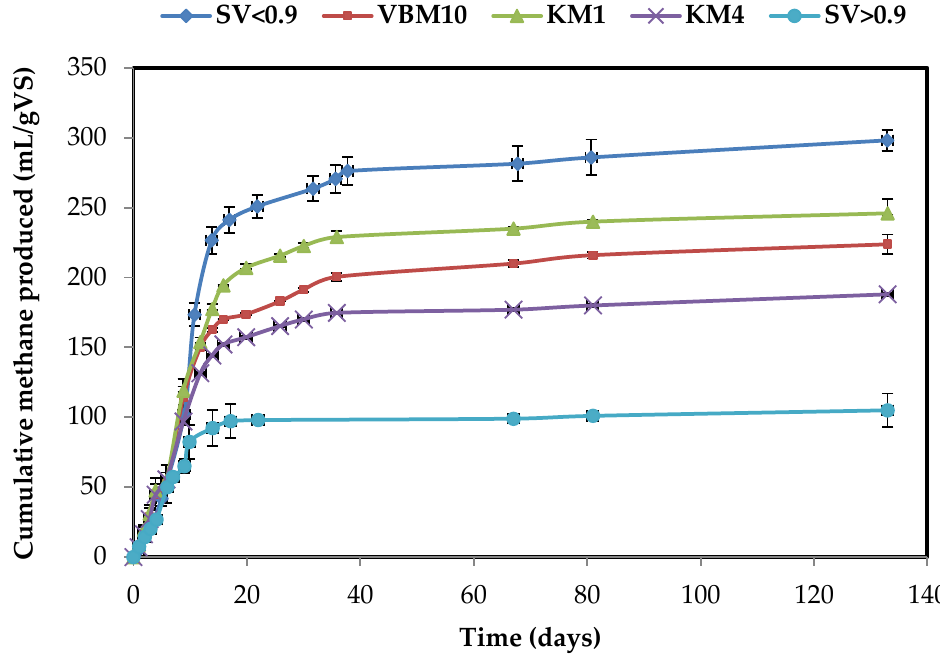
Figure 3. Cumulative methane production for different dry fractionation process of M olive pomace from traditional extraction process.